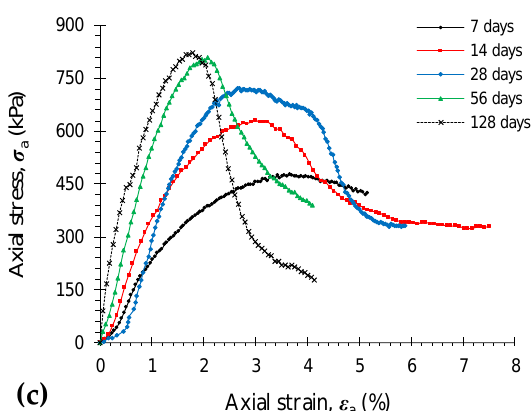
Figure A1. UC stress–strain curves for various MC-treated mixtures: ( a ) M 1.5 F 0 T z ; ( b ) M 2.5 F 0 T z ; ( c ) M 3.0 F 0 T z ( z = {7, 14, 28, 56, 128}). Stress–strain curves, obtained from the UC tests, for various MC + FA-treated mixtures— M x F y T z where x = {1.5, 2.5}, y = {0.5, 1.0, 1.5, 2.0, 2.5} and z = {7, 14, 28, 56, 128}—are provided in Figure A2.